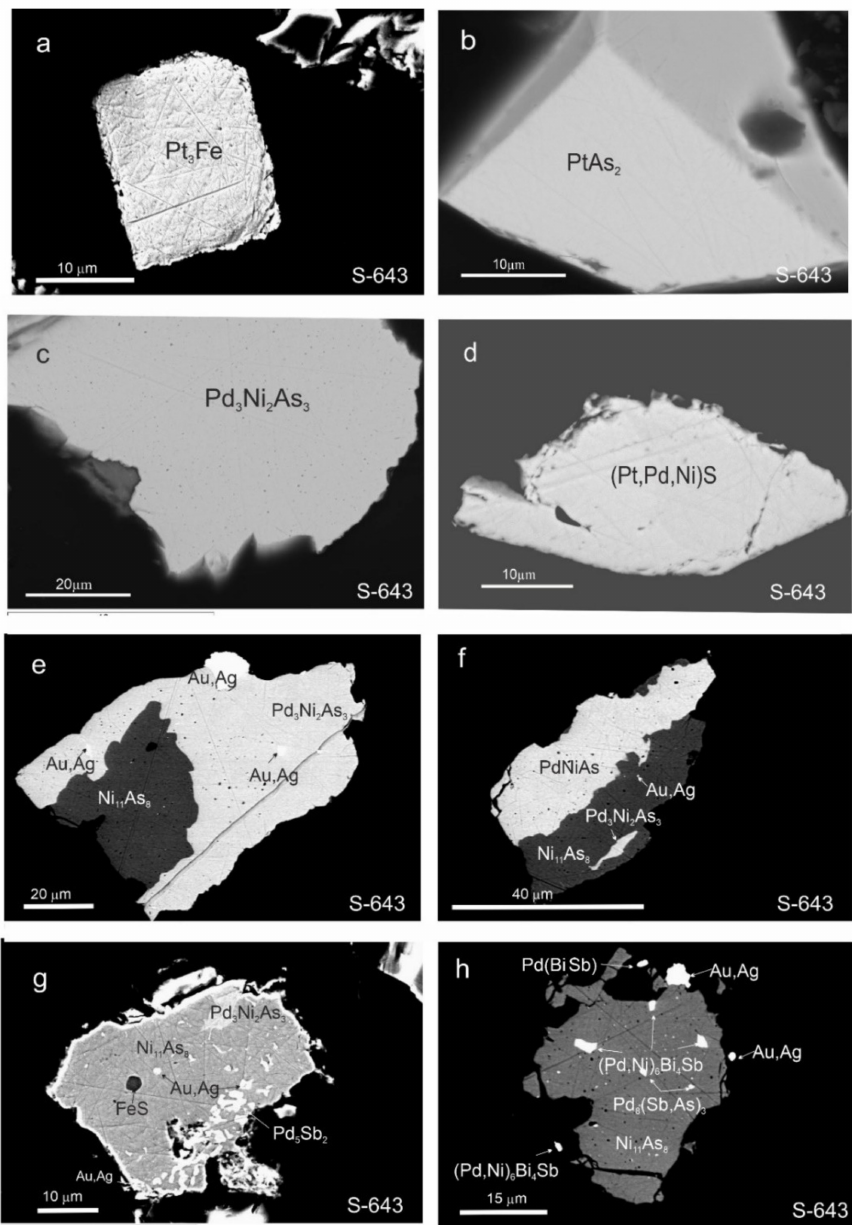
Figure 8. SEM image showing the morphology and microparageneses of PGM, sample S-643: ( a ) iso- ferroplatinum grain; ( b ) sperrylite crystal; ( c ) menshikovite grain; ( d ) cooperate grain; ( e , f ) inter- growths of menshikovite Pd 3 Ni 2 As 3 and maucherite Ni 11 As 8 ; ( g,h ) inclusions of PGM, sulfide, and gold (Au,Ag) in